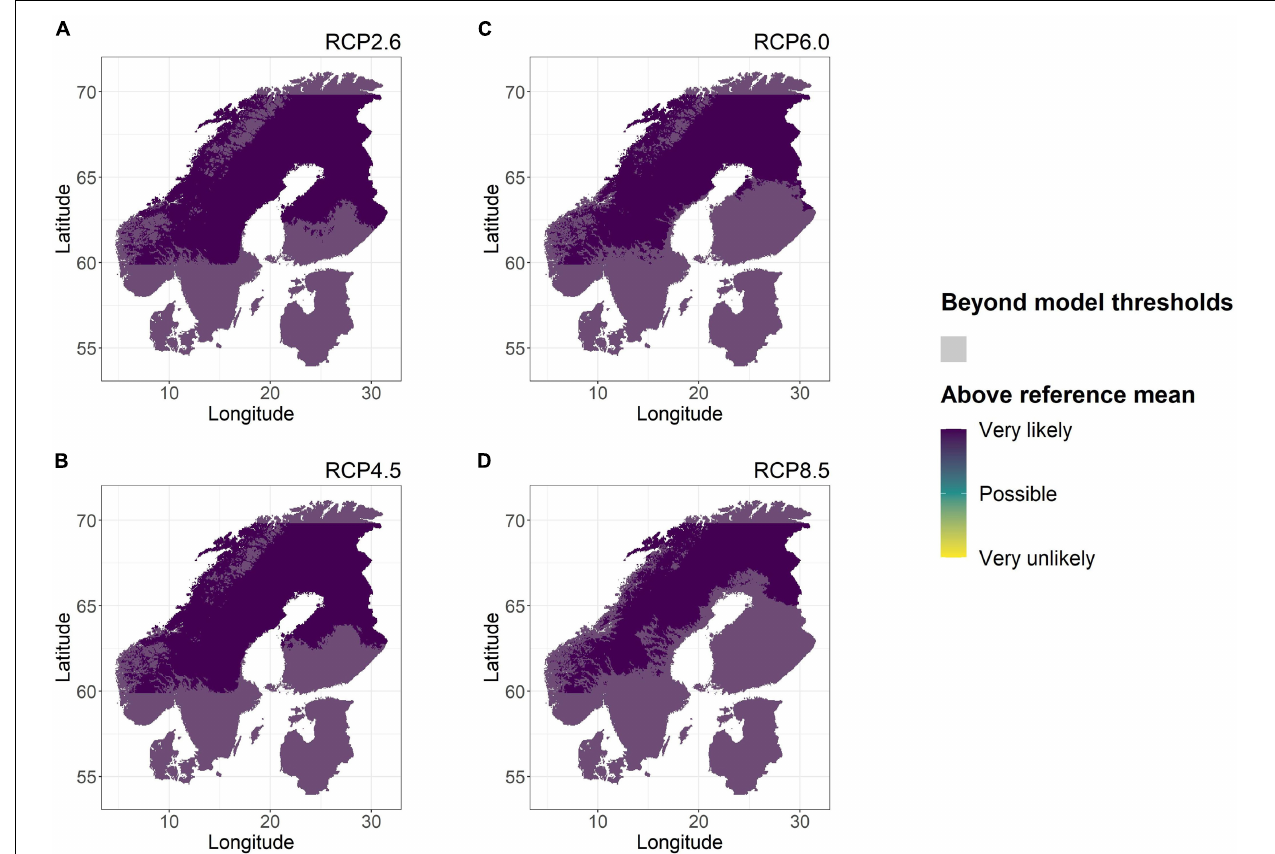
FIGURE 3 | Likelihood of tree height increase for Scots pine in the Nordic region under four future climate scenarios (RCP) in comparison to that of the reference period (1961–1990). The probability was assessed as the agreement among five GCMs within each RCP on tree height increase based on model predictions for RCPs 2.6 (A) , 4.5 (B) , 6.0 (C) , and 8.5 (D) . All locations where environmental variables exceeded those of the model data range according to at least three GCMs have been dimmed in semi-transparent